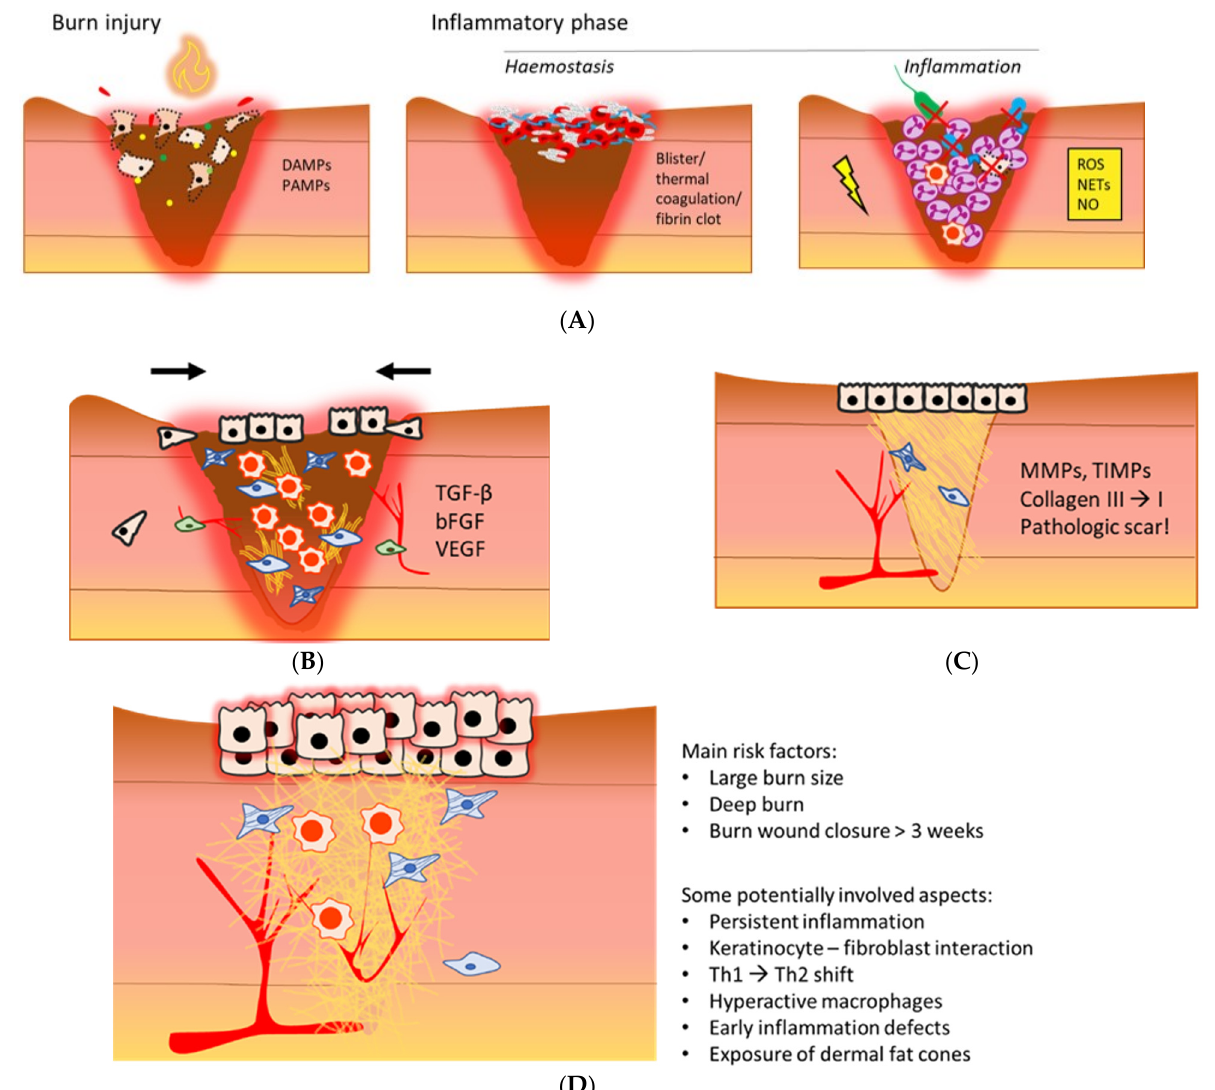
Figure 1. An illustrative overview of the post-burn inflammatory phase ( A ), proliferation phase ( B ), remodelling phase ( C ), and a hypertrophic scar ( D ) [6–10]. ( A ) Necrotic tissue and infiltrating pathogens post-burn initiate an inflammatory response that is mediated by local increases in DAMPs and PAMPs. Depending on burn depth, haemostasis is maintained via blister formation, thermal coagulation of dermal blood vessels, or activation of the coagulation cascade. During inflammation, neutrophils, the complement system and macrophages are main contributors to pathogen elimination and necrotic tissue clearance, mainly via phagocytosis and oxidative stress. Persistent inflammation could further damage the wound bed. DAMPs: damage-associated molecular patterns; PAMPs: pathogen-associated molecular patterns; ROS: reactive oxygen species; NETs: neutrophil extracellular traps; NO: nitric oxide. ( B ) The anti-inflammatory macrophage is a dominant immune cell in this phase. Proliferation is characterised by formation of granulation tissue, reepithelisation, angiogenesis and wound contraction, mediated by a variety of cytokines and growth factors. TGF- β : transforming growth factor β ; bFGF: basis fibroblast growth factor; VEGF: vascular endothelial growth factor. ( C ) Remodelling increases scar tissue strength, and important proteins in this phase are MMPs and TIMPs. The outcome of the local wound healing phases post-burn often is a pathological scar. MMPs: matrix metalloproteinases; TIMPs: tissue inhibitors of matrix metalloproteinases. ( D ) A hypertrophic scar is red, rigid and raised. A typical aspect is excessive ECM deposition. The main risk factors of HTS formation and potentially involved causal aspects are summarised on the